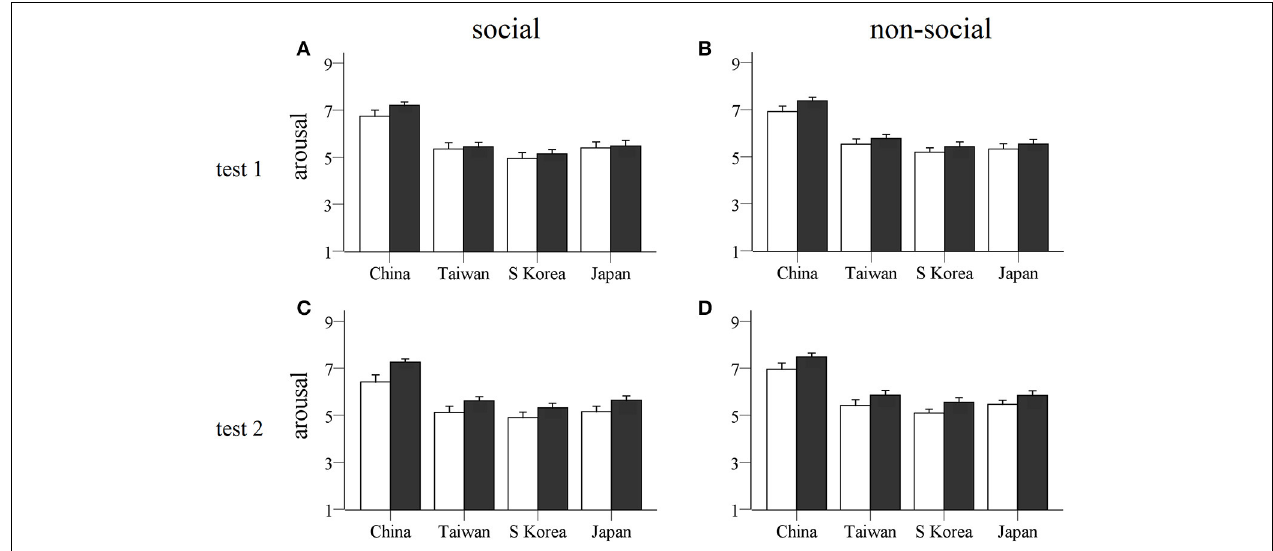
FIGURE 4 | Arousal ratings for stimulus pictures from each country. Histograms show mean ± s.e.m. arousal ratings of social (A,C) and non-social (B,D) stimulus pictures for four different countries given by OXT